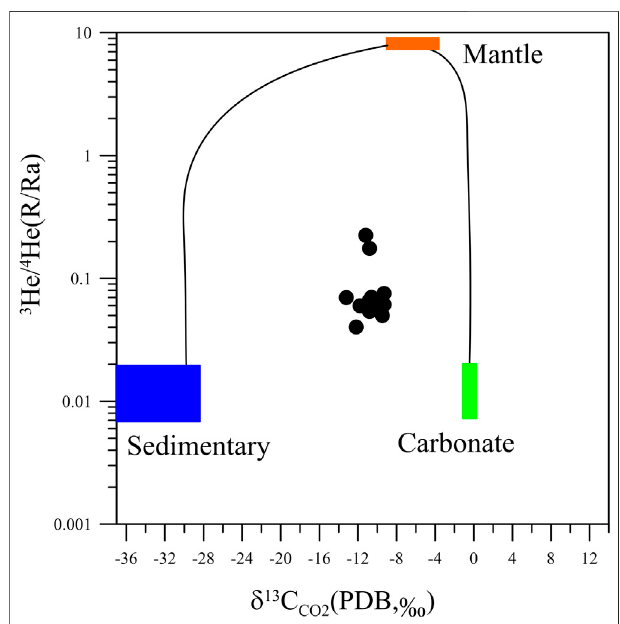
FIGURE 6 | Diagram of 3 He/ 4 He (R/Ra) vs. δ 13 C CO2 (PDB, ‰ )